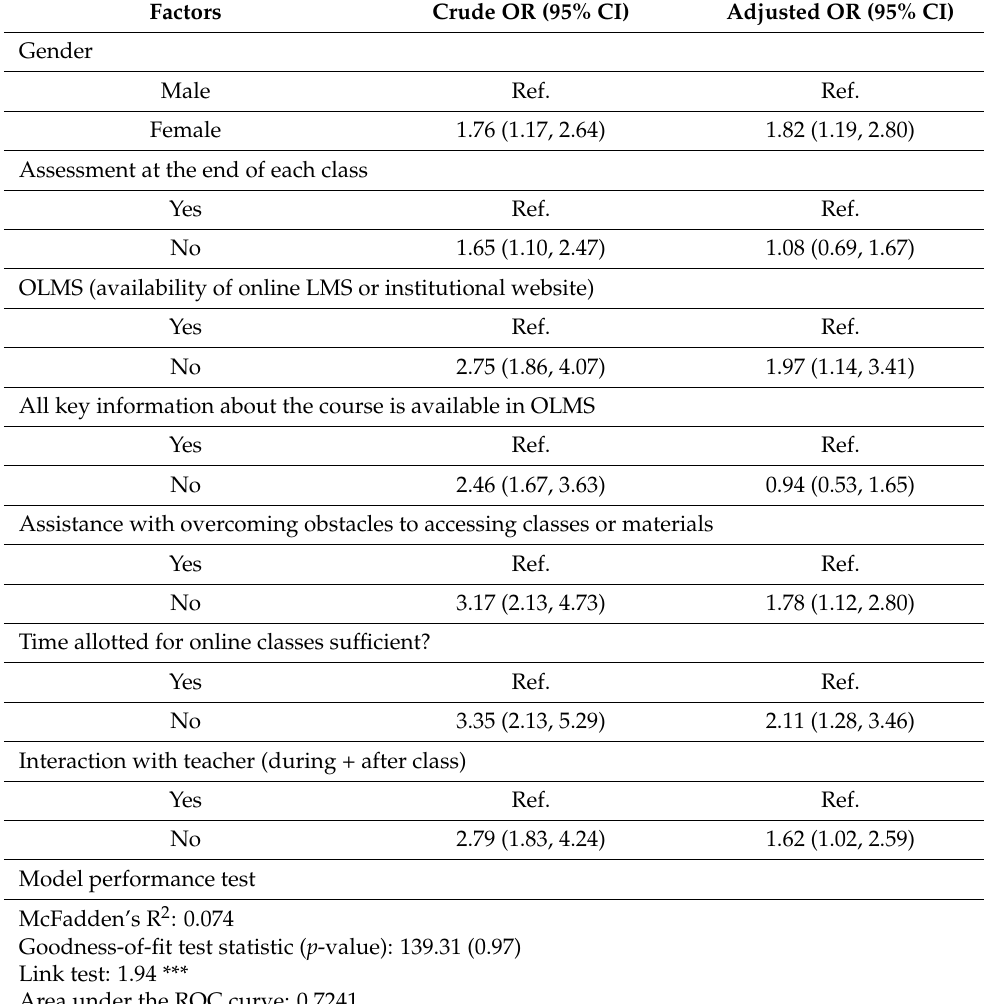
Table 3. The factors associated with dissatisfaction with online classes among the overall study population. Factors Crude OR (95% CI) Adjusted OR (95% CI) Gender Male Ref. Ref.